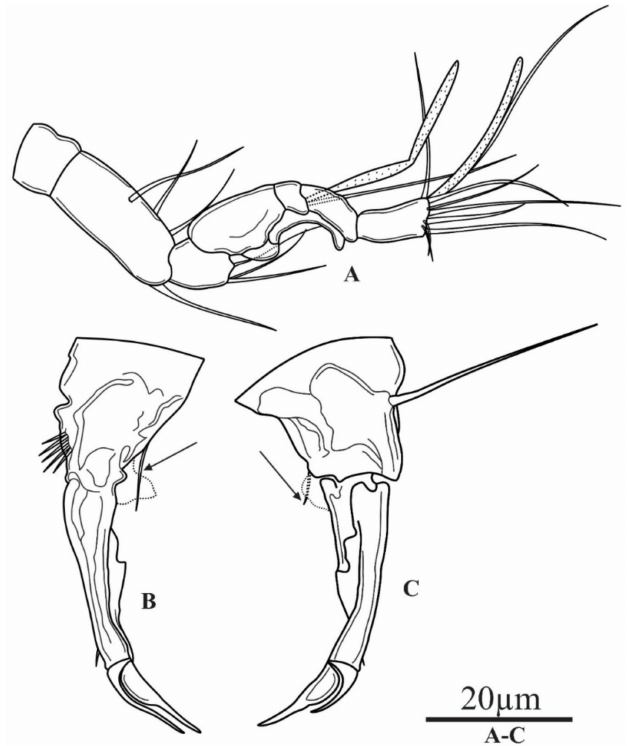
Figure 8. Parastenocaris sontraensis sp. nov. male. ( A ), antennule; ( B ), P3 posterior view; ( C ), P3 anterior view. The arrow indicates reduced End.